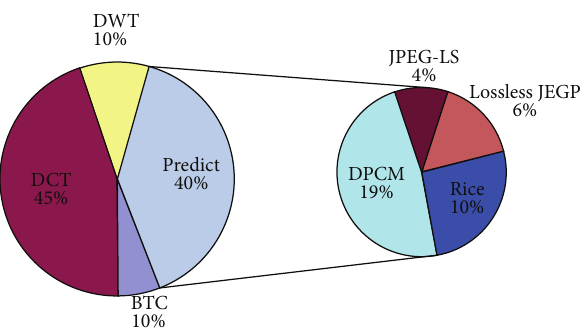
Figure 1: The statistics result of on-board image compression.